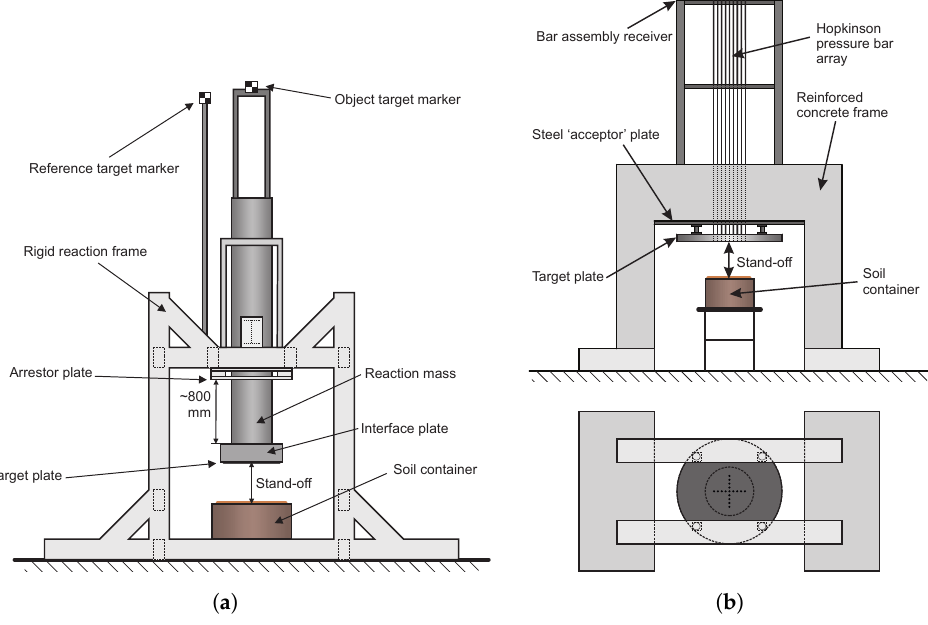
Figure 2. The two experimental setups at the University of Sheffield. ( a ) FFM (from Figure 3 of Clarke et al. [28]). ( b ) CoBL (from Figure 2 of Rigby et al.